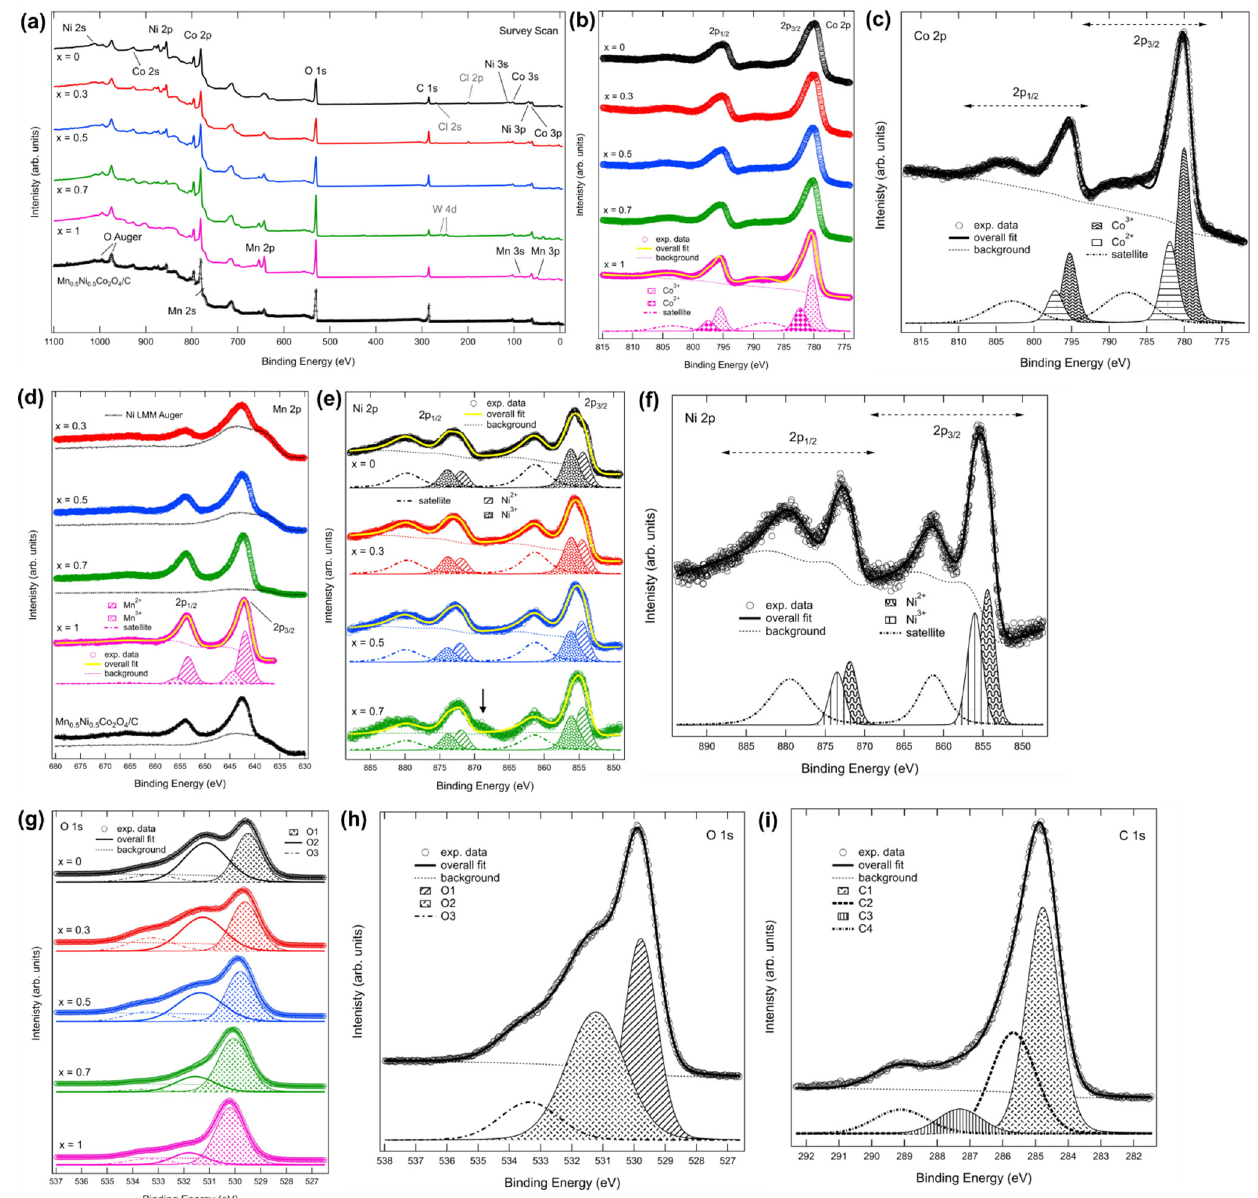
Figure 4. ( a ) Wide survey scans of the MnNiCoO and Mn 0.5 Ni 0.5 Co 2 O 4 /C samples, ( b ) Co 2p core-level spectra of MnNiCoO, ( c ) Co 2p core-level spectra of Mn 0.5 Ni 0.5 Co 2 O 4 /C samples, ( d ) Mn 2p core-level spectra of the MnNiCoO and Mn 0.5 Ni 0.5 Co 2 O 4 /C samples, ( e ) Ni 2p core-level spectra of Mn x Ni 1 − x Co 2 O 4 , ( f ) Ni 2p core-level spectra of Mn 0.5 Ni 0.5 Co 2 O 4 /C samples, ( g ) O 1s core-level spectra of MnNiCoO, ( h ) O 1s core-level spectra of Mn 0.5 Ni 0.5 Co 2 O 4 /C samples, and ( i ) C 1s core-level spectrum of the Mn 0.5 Ni 0.5 Co 2 O 4 /C sample.